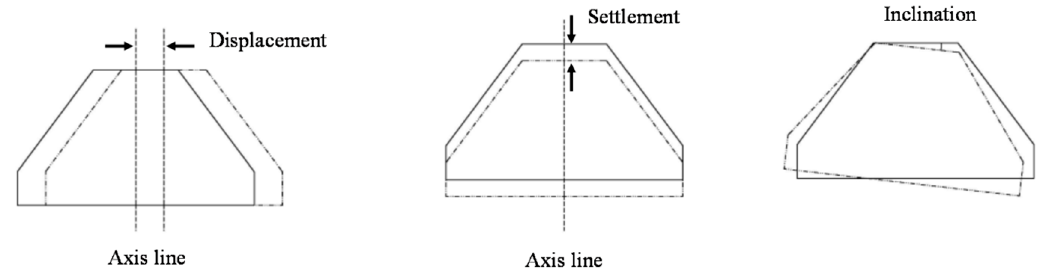
Figure 9. The three damage patterns of spur dikes with tooth-shaped structures [24].